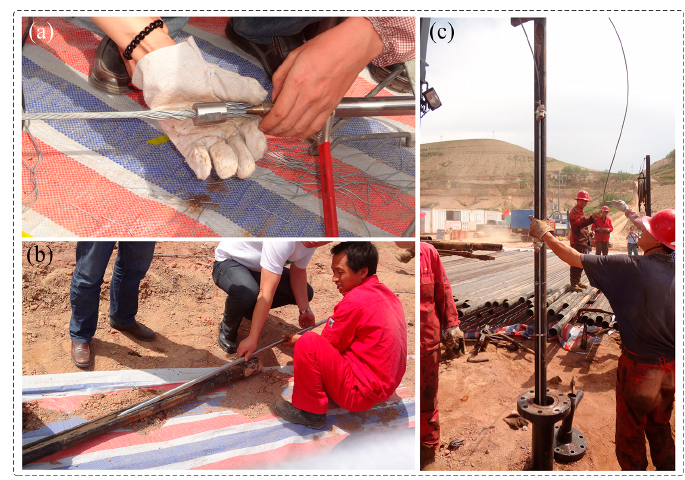
Figure 22. Photos of well-logging field: ( a ) Downhole cable; ( b ) Tied to the downhole tube; ( c ) Sensor down well process.